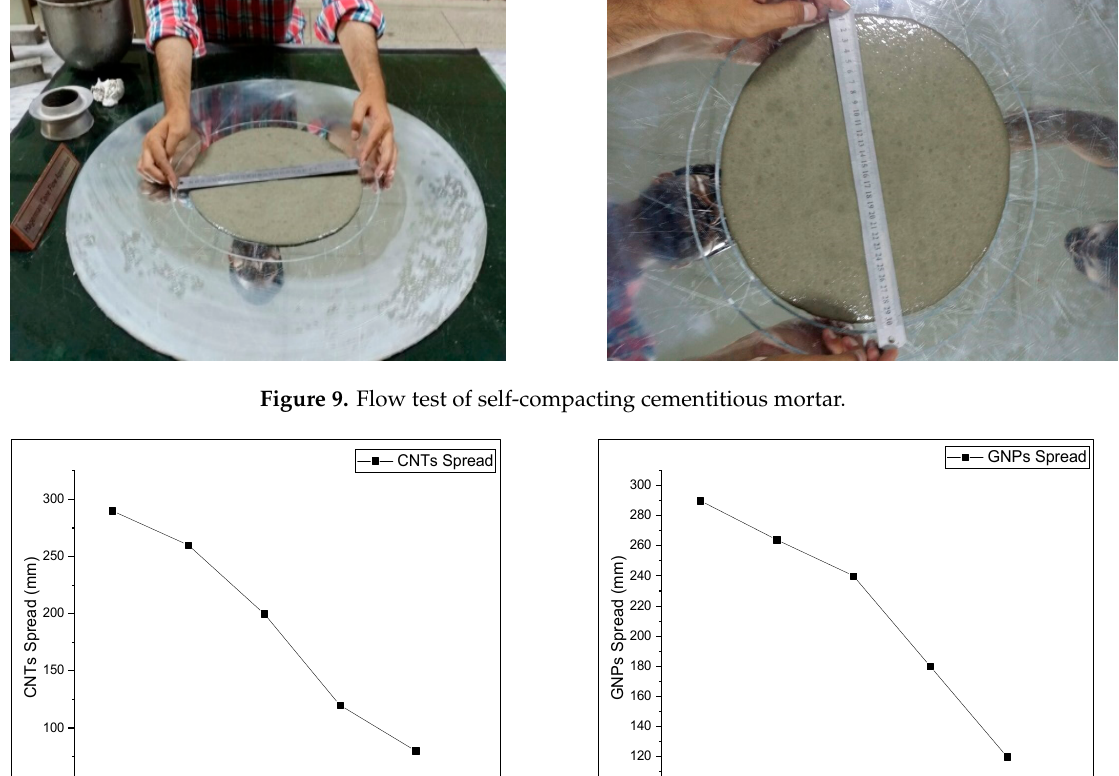
Figure 10. CNTs and GNPs spread using a mini-slump cone by varying different dosages.